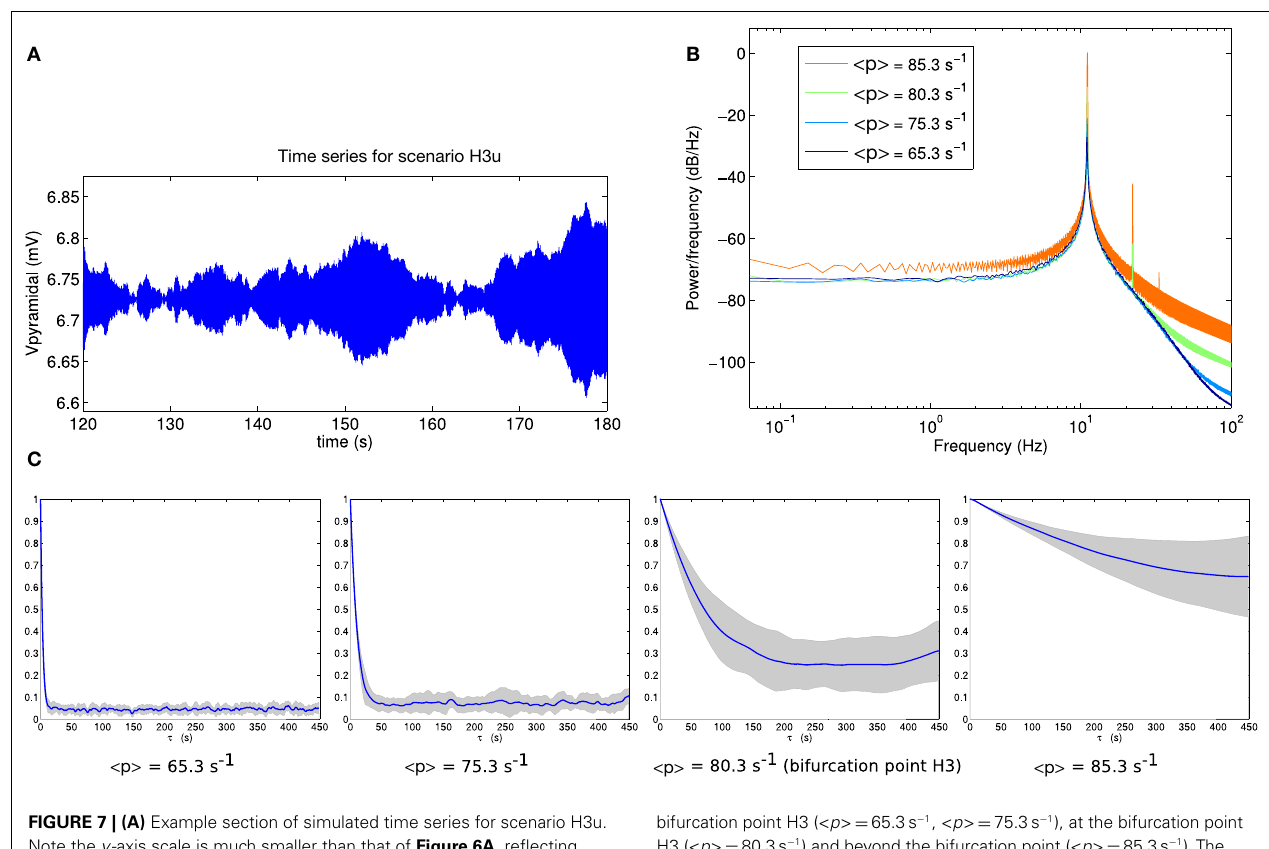
FIGURE 7 | (A) Example section of simulated time series for scenario H3u. Note the y -axis scale is much smaller than that of Figure 6A , reflecting much smaller output variance in this case. (B) Power spectrum at H3. (C) Autocorrelation amplitude at points in parameter space approaching the